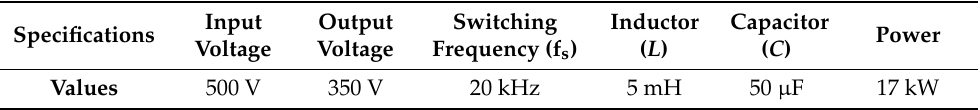
Table 9. Design specification of the buck converter.